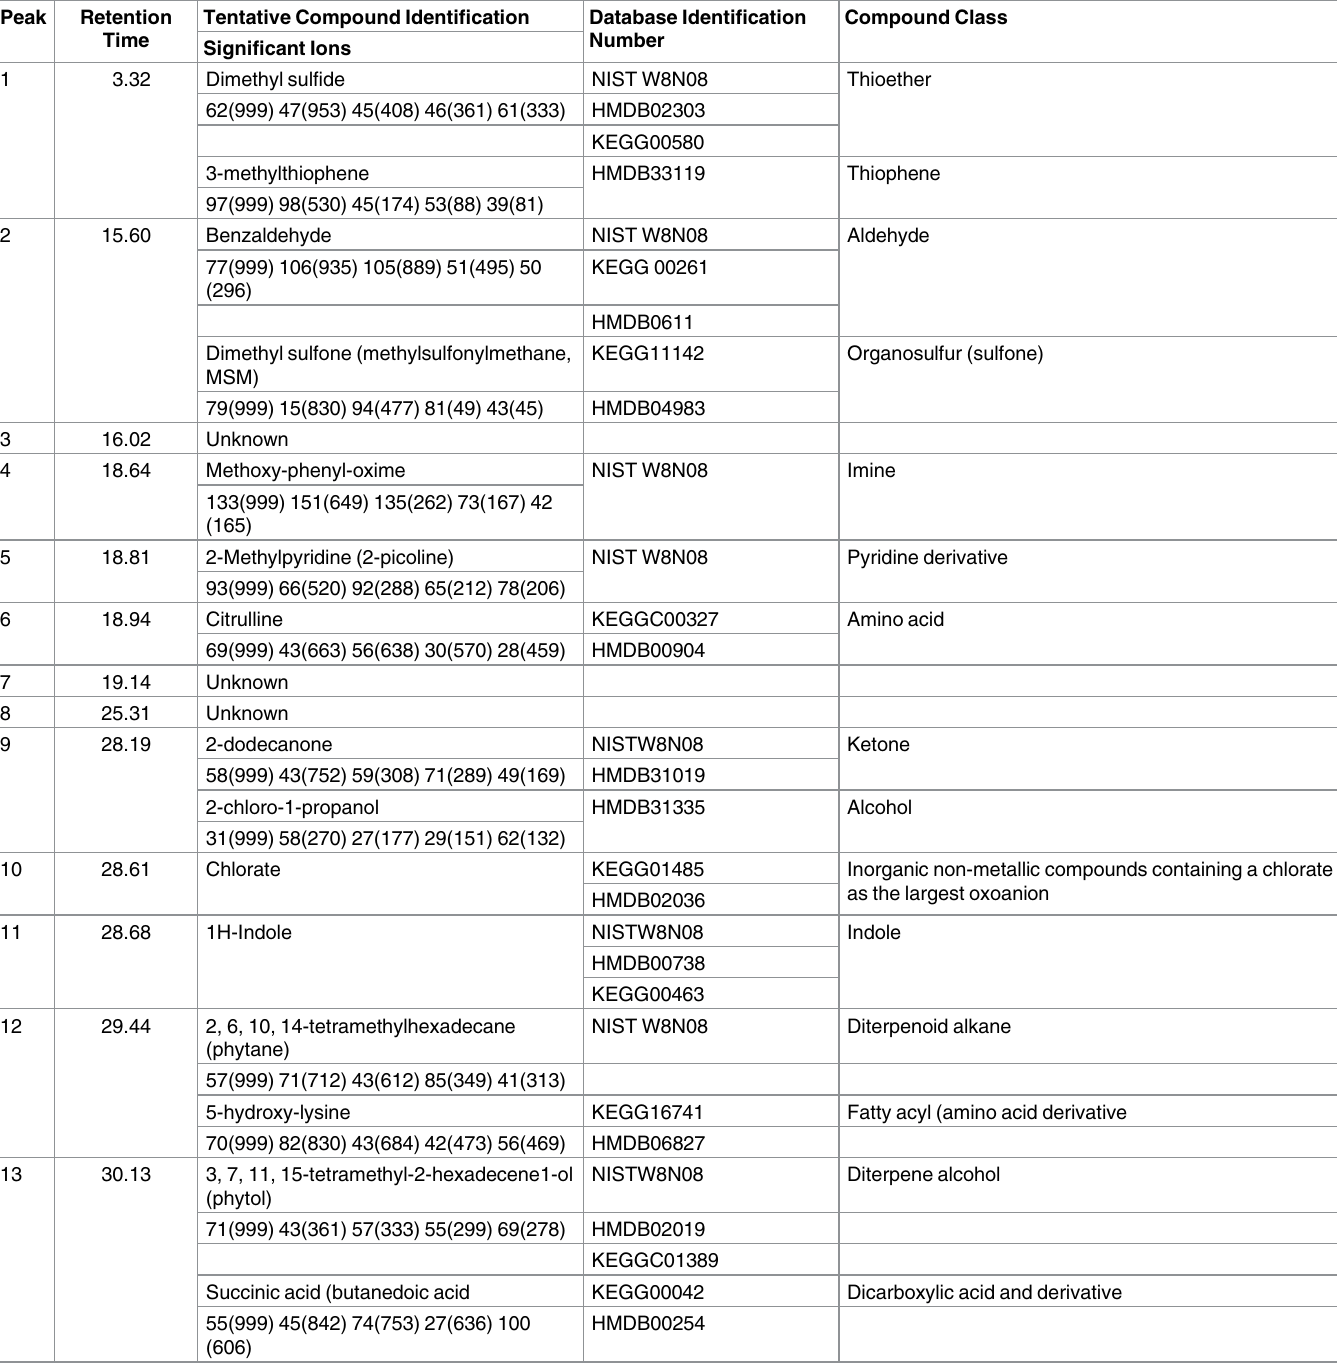
Table 4. Tentative compound identification of chromatographic